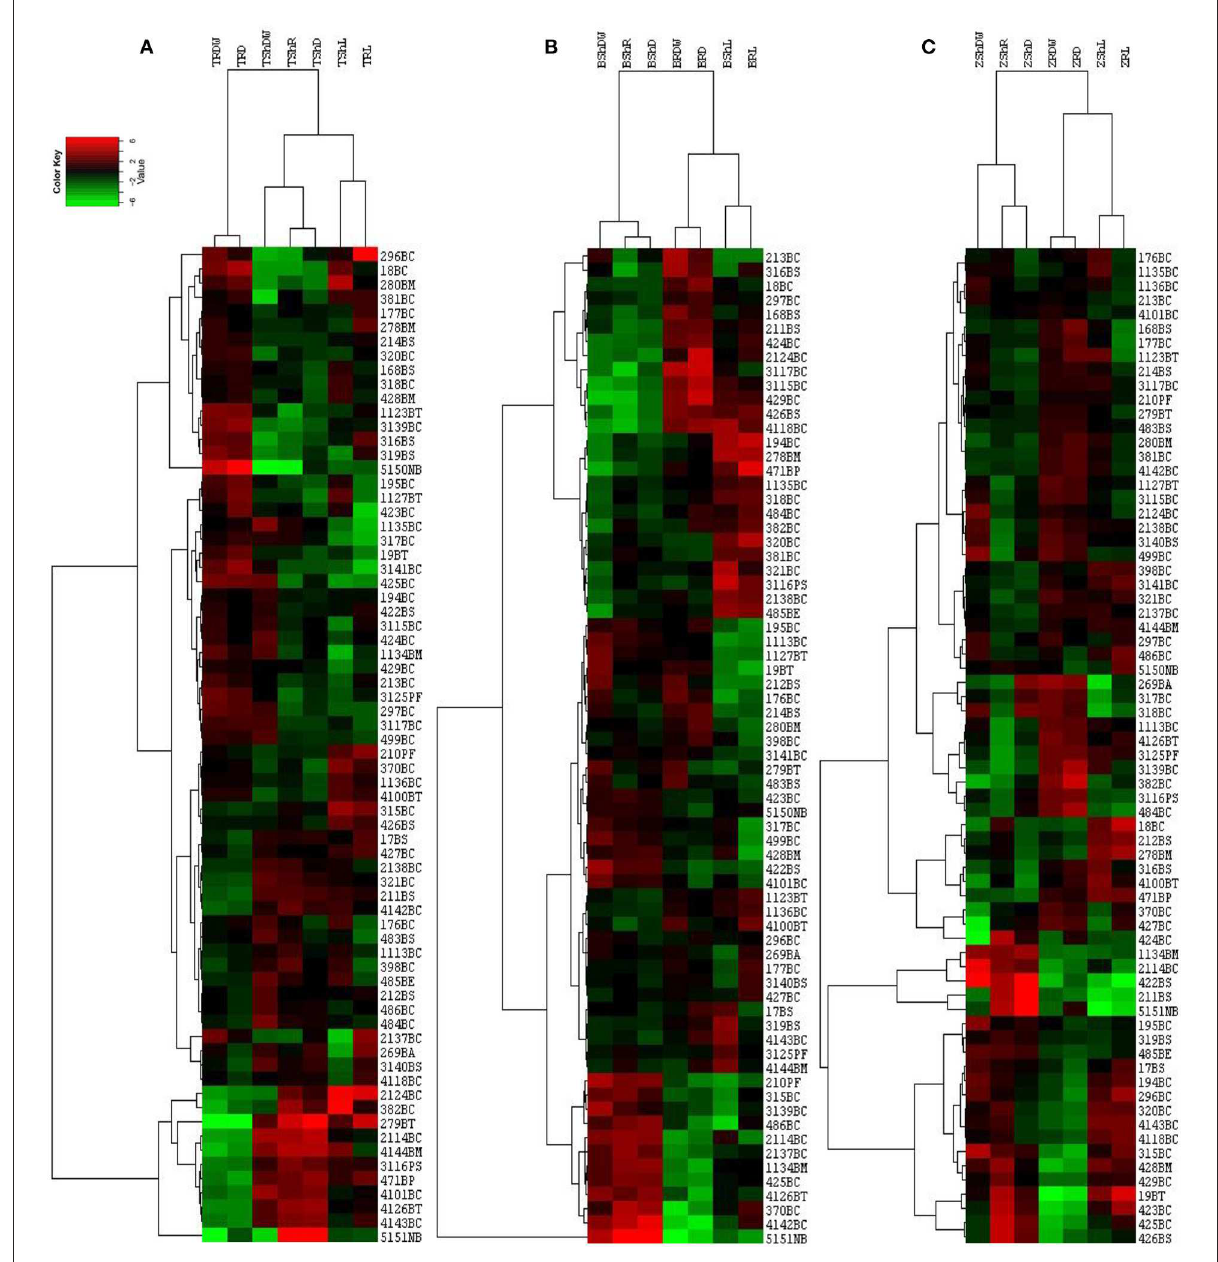
FIGURE4 Hierarchical cluster analysis of effect of isolates on wheat (A) , canola (B) , and maize (C) plants, drawn by CLUSTER and Treeview softwares. The horizontal axis shows the plant growth parameters in abbreviation format and the vertical axis shows the bacterial isolates (see Supplementary Table S6). Sh, Shoot; R, Root; L, Length; DW, Dry Weight; D, Density; T, wheat; B, canola; Z, maize or the combination of these